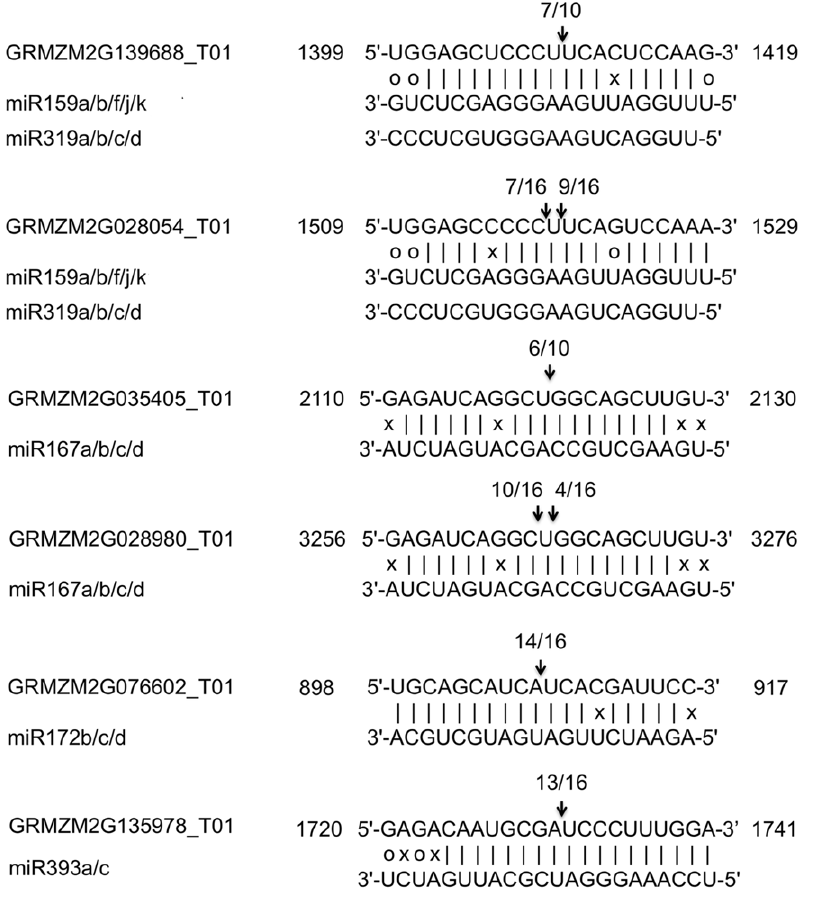
Figure 8. 5 9 -RLM-RACE verification of predicted miRNA targets. Each top strand depicts a miRNA complementary site (targets), and each bottom strand depicts the miRNA. miR159 and miR319 shares the target sequence. Watson-Crick pairing (vertical dashes) and G:U wobble pairing (circles) are indicated. Arrows indicate the 5 9 termini of mRNA fragments isolated from roots of the maize seedlings, as identified by cloned 5 9 -RACE products, with the frequency of clones shown. Only cloned sequences that matched the correct target gene and had 5 9 ends within a 100 nt window centered on the miRNA complementary site are counted.